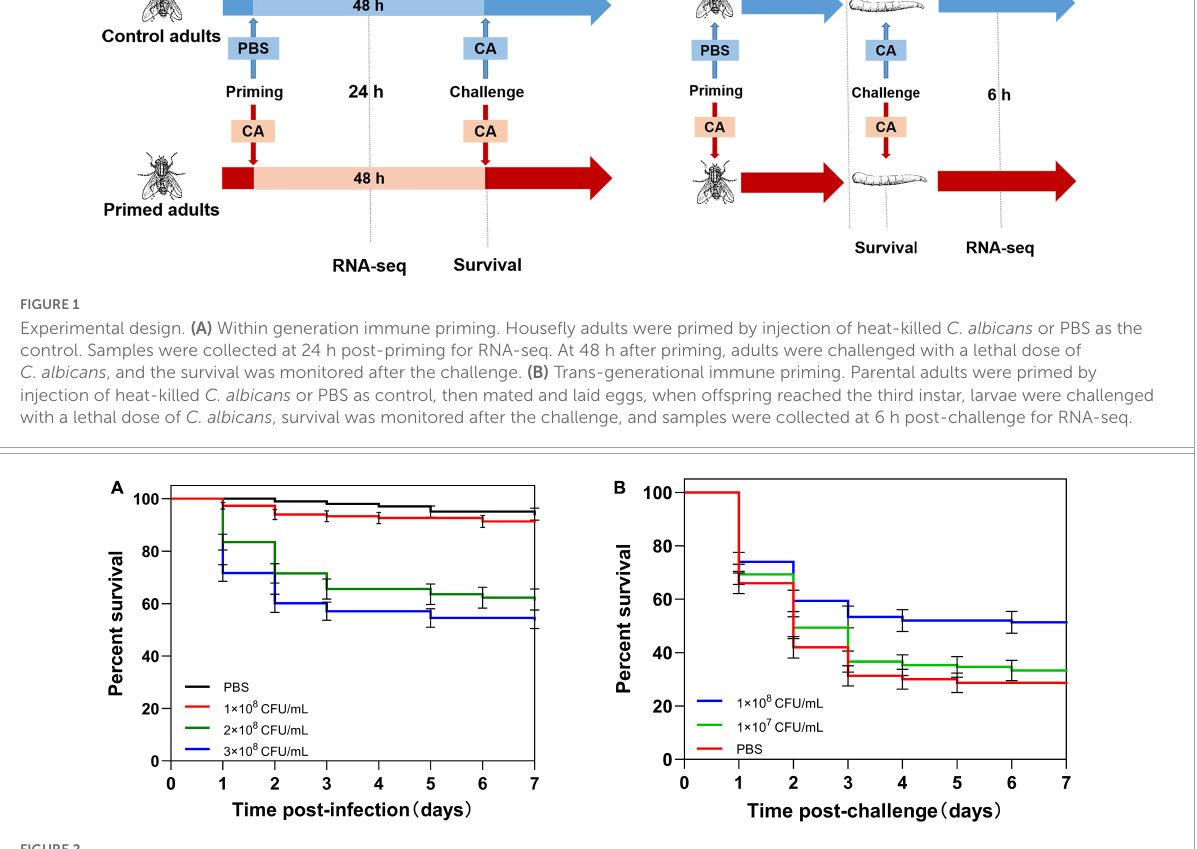
FIGURE2 Survival of housefly adults after infection. (A) Adults were injected with different concentrations (1 × 10 8 , 2 × 10 8 , or 3 × 10 8 CFU/ml) of C. albicans or PBS. (B) Adults were first primed with different concentrations (1 × 10 7 or 1 × 10 8 CFU/ml) of heat-killed C. albicans or PBS, then challenged with a lethal dose of C. albicans. The survival data of each condition were generated from three replicates, and each had 50 adults. The survival difference was compared using the Log-rank test of the Kaplan-Meier survival analysis. The results are reported as mean ± SE from three independent